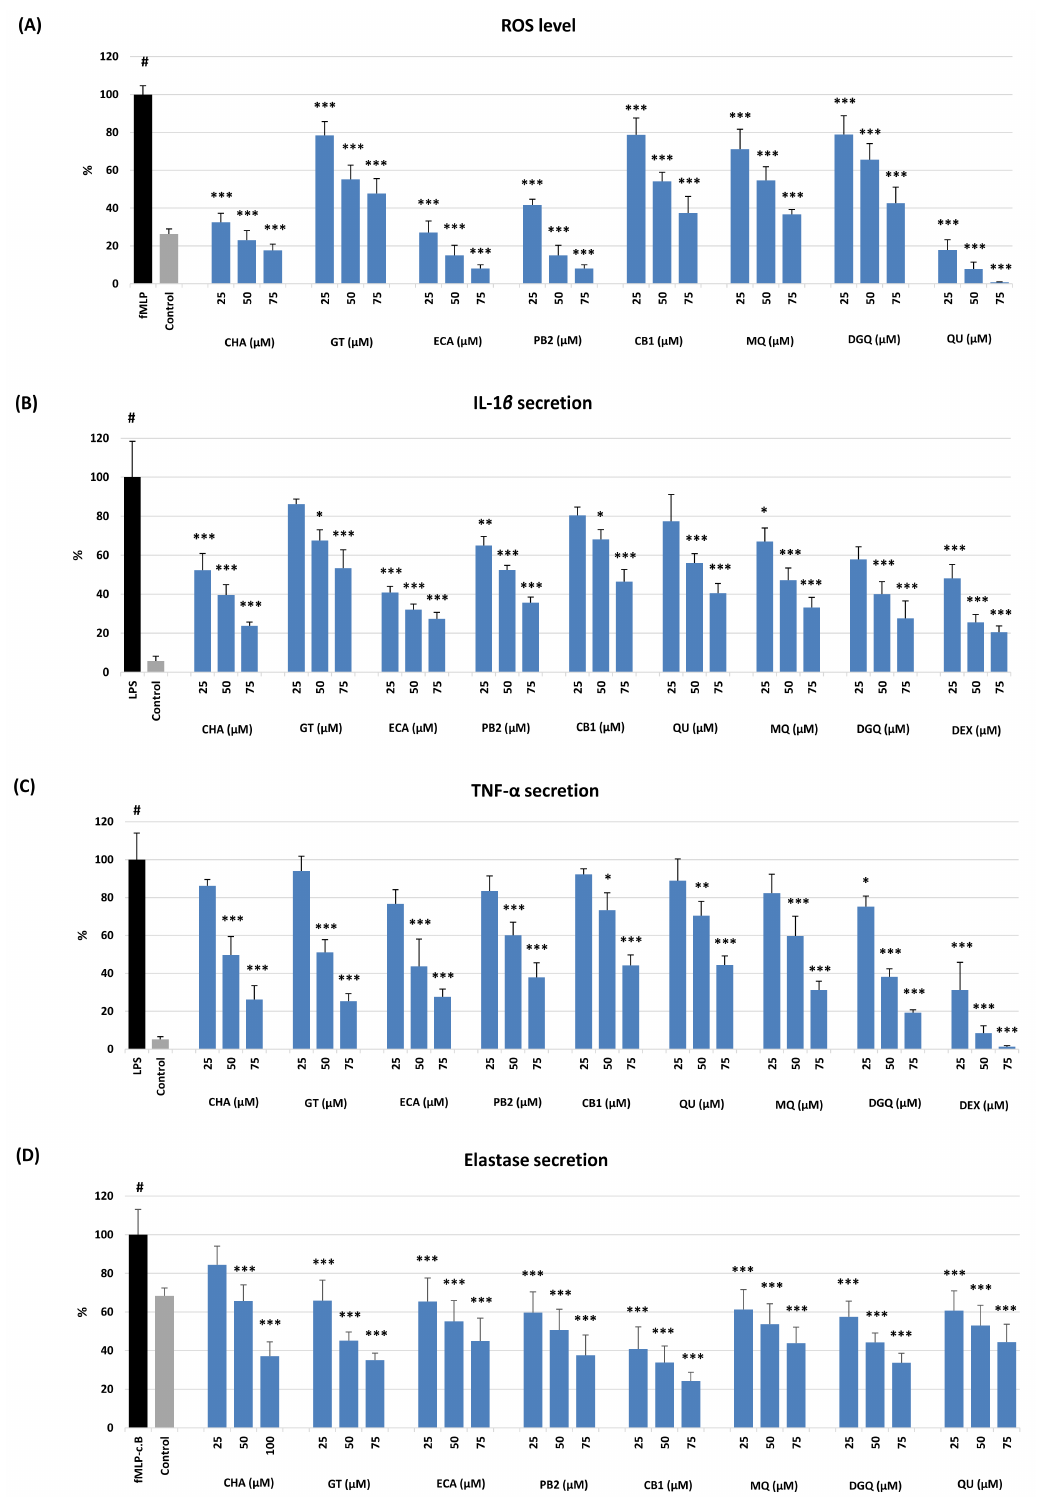
Figure 4. Effect of the selected compounds at 25–75 µ M on: ( A ) ROS production and secretion of ( B ) IL-1 β , ( C ) TNF- α , and ( D ) ELA-2 by stimulated human neutrophils. Data expressed as means ± SD of three independent experiments performed with cells isolated from five independent donors. Statistical significance: # p < 0.001 compared to the non-stimulated control; * p < 0.05, ** p < 0.01, *** p < 0.001 compared to the stimulated control. Analytes: QU, quercetin; MQ, miquelianin; DGQ, wintergreenoside A; ECA, ( − )-epicatechin; PB2, procyanidin B2; CB1, cinnamtannin B-1; CHA, chlorogenic acid; GT, gaultherin. Positive controls: ( A , D ) QU, quercetin; ( B , C ) DEX,